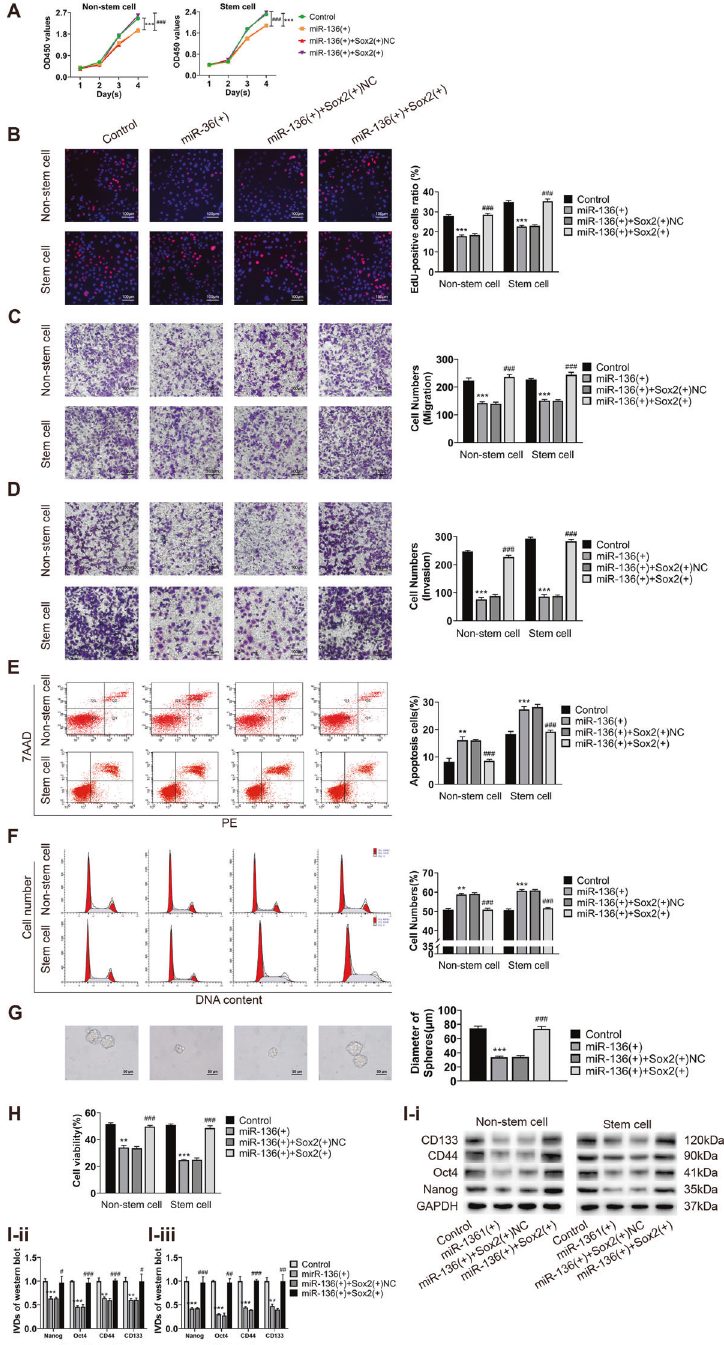
Fig. 5 Sox2 can restore the inhibitory effect of miR-136 on malignant behavior of ECCs and ECSCs. A , B Effects of co-transfected miR-136 and Sox2 on proliferation in endometrial cancer non-stem cells and stem cells evaluated by CCK8 and EdU assays. C Effects of co-transfected PVT1 and miR-136 on cell migration in endometrial cancer non-stem cells and stem cells evaluated by transwell assays. D Effects of co- transfected miR-136 and Sox2 on cell invasion in endometrial cancer non-stem cells and stem cells evaluated by transwell assays. E Effects of co-transfected miR-136 and Sox2 on cell apoptosis in endometrial cancer non-stem cells and stem cells evaluated by fl ow cytometry. F Effects of co-transfected miR-136 and Sox2 on the cell cycle (G0/G1 phase) in endometrial cancer non-stem cells and stem cells evaluated by fl ow cytometry. G Effects of co-transfected miR-136 and Sox2 on cell self-renewal capacity in ECSCs evaluated by sphere formation assays. H Effects of co-transfected miR-136 and Sox2 on resistance of CBP in endometrial cancer non-stem cells and stem cells evaluated by CCK8. I Effects of co-transfected miR-136 and Sox2 on stemness markers (CD133, CD44, Oct4, and Nanog) in endometrial cancer non-stem cells and stem cells evaluated by western blot. Data are presented as the means ± SD ( n = 3, each group), * P < 0.05, ** P < 0.01, *** P < 0.0001 vs. control group; # P < 0.05, ## P < 0.01 and ### P < 0.001 vs. miR-136( + ) + Sox2( + )NC group.